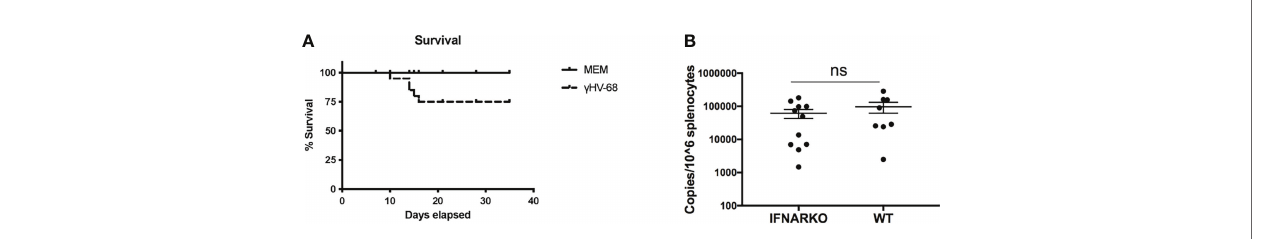
FIGURE 1 | A low dose of g HV-68 is able to infect and establish latency in WT and IFNARko mice. (A) IFNARko mice were infected with 100 pfu of g HV-68. Survival rate in IFNARko mice was 75%. (B) 5 weeks p.i. IFNARko mice establish latency at similar rates than WT mice. Three independent experiments with 7-11 recipient mice/group. Data analyzed with Student ’ s t-test was not signi fi